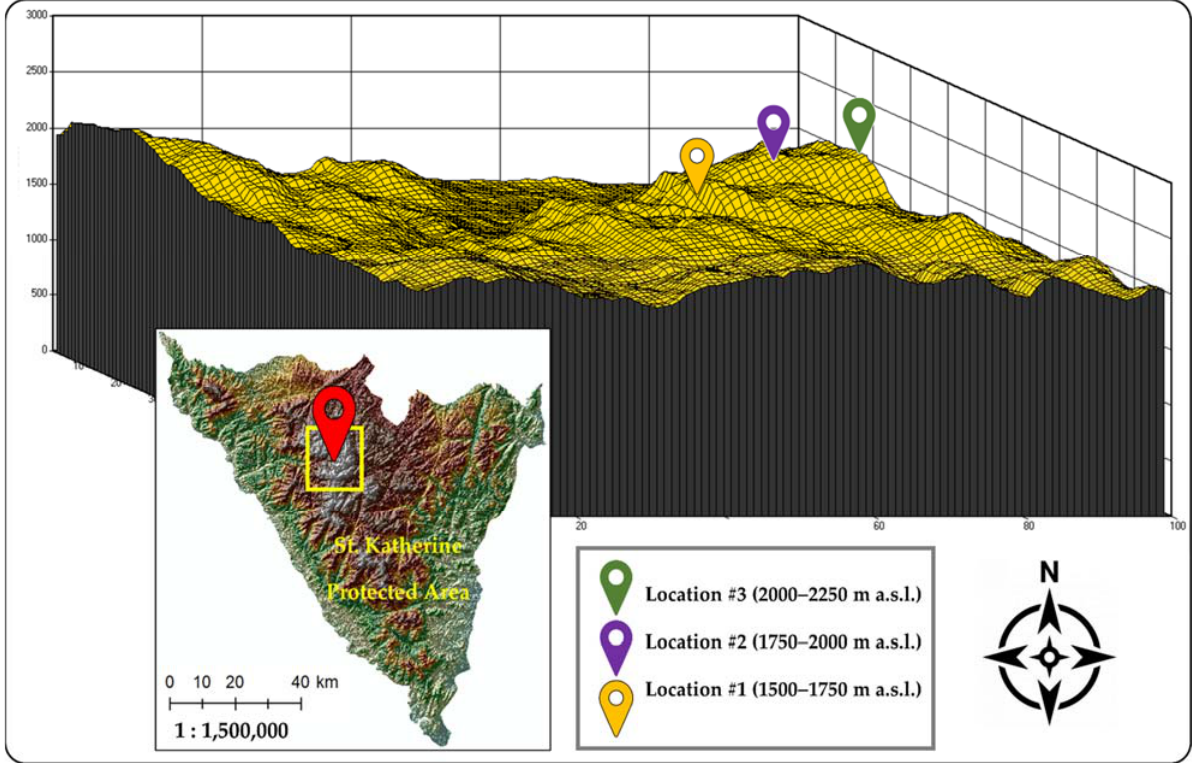
Figure 2. Surface profile showing the three locations of data collection at different altitudes in Saint Katherine protectorate.